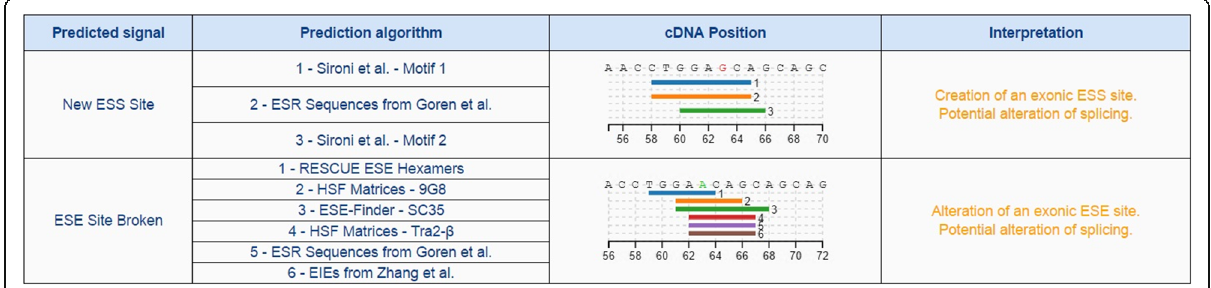
Fig. 2 HSF output for pathogenic effect prediction of the E21E